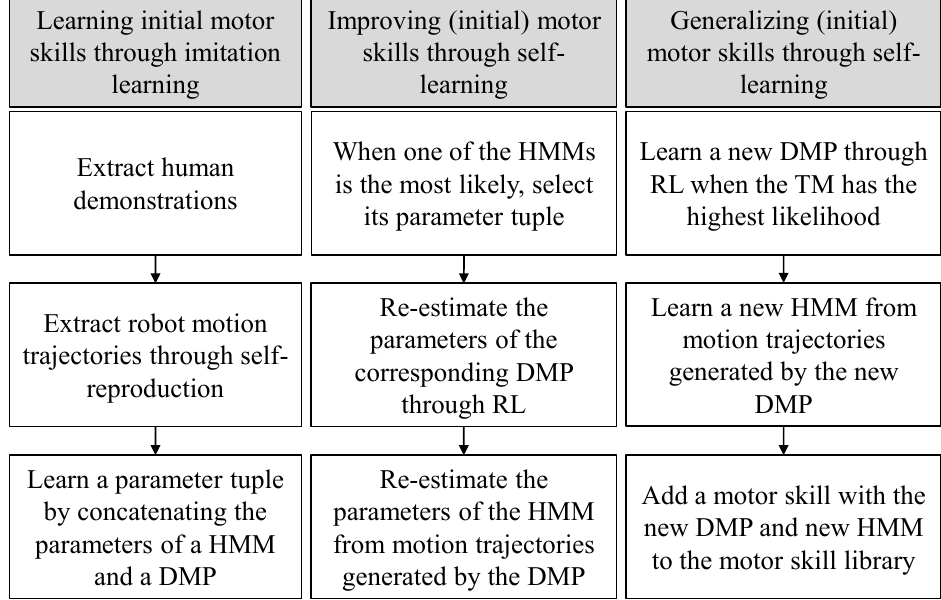
Figure 1. The proposed framework consists of three processes: ( left ) learning initial motor skills through imitation learning; ( middle ) improving the (initial) motor skills through RL; and ( right ) generalizing them with